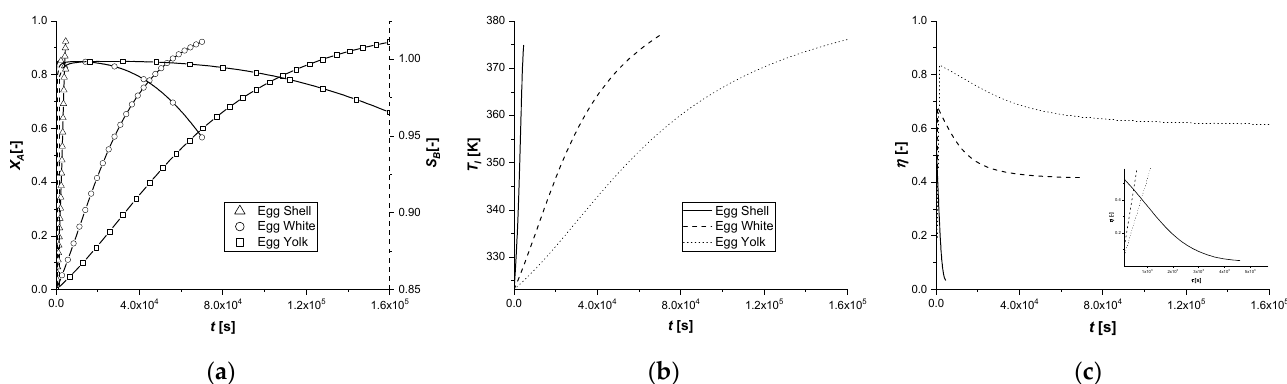
Figure 4. ( a ) Bulk profiles over time for ES, EW, and EY. Calculated profiles for: X A and S B . ( b ) Bulk profiles over time for EY, EW, and EY. Calculated profiles for: T l . ( c ) Catalytic effectiveness factor profiles over time for ES, EW, and EY.